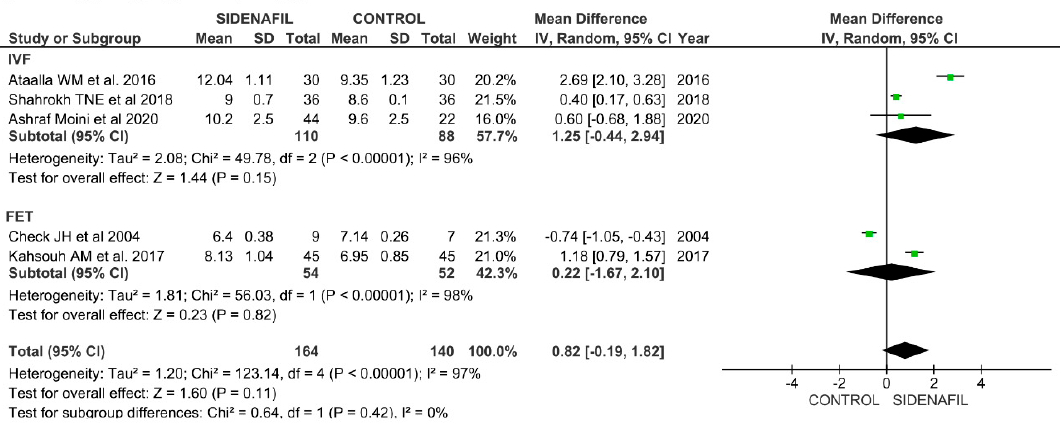
Figure 3. ( a ) Forest plot of comparison: endometrial thickness (ETh) according to group allocation—intervention (Sildena- fil) versus control in IVF fresh and frozen embryo transfer. ( b ) Forest plot of comparison: clinical pregnancy rate (CPR) according to group allocation—intervention (Sildenafil) versus control in IVF fresh and frozen embryo transfer. ( c ) Forest plot of comparison: chemical pregnancy rate (ChPR) according to group allocation—intervention (Sildenafil) versus con- trol in IVF fresh and frozen embryo transfer.